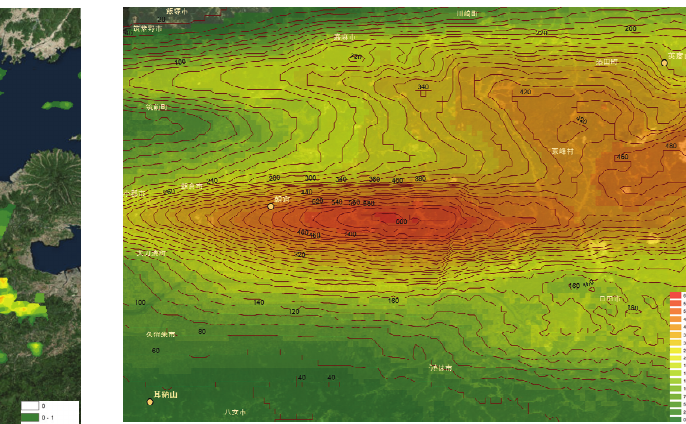
Figure 14. Analysis of rainfall data collected by the X-band MP radar (2017.7.5